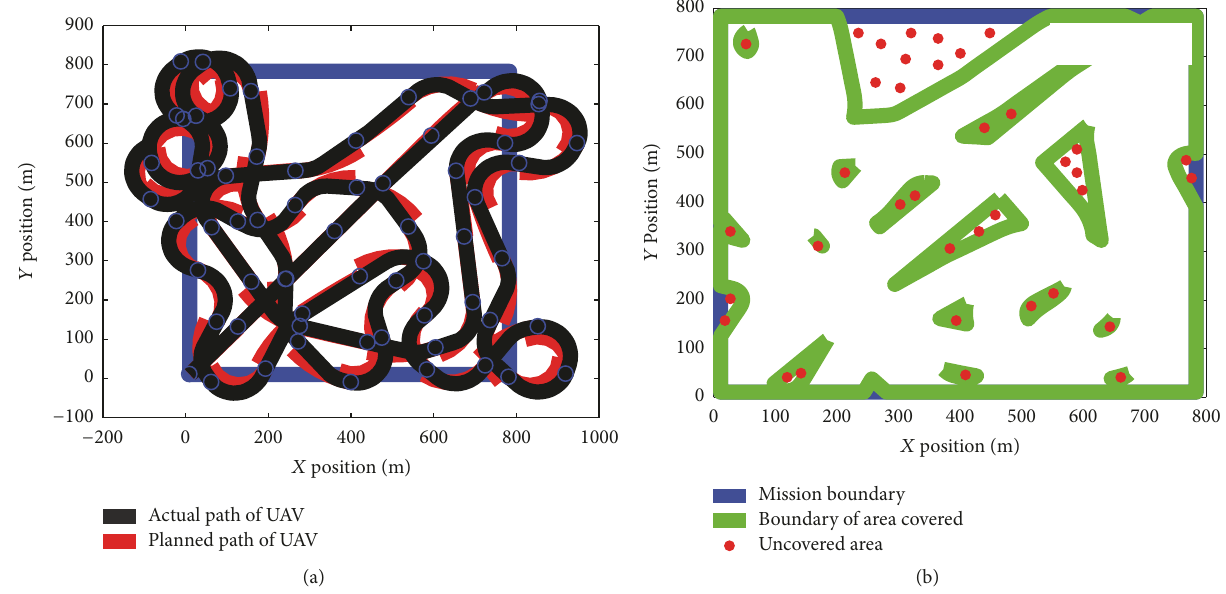
Figure 10: (a) Comparison of planned path and actual path. The actual path presented is the path from the 6-DOF simulation generated from desired turning rate. The planned path is a path generated using the 3-DOF Dubins model. (b) Area covered by the vehicle.